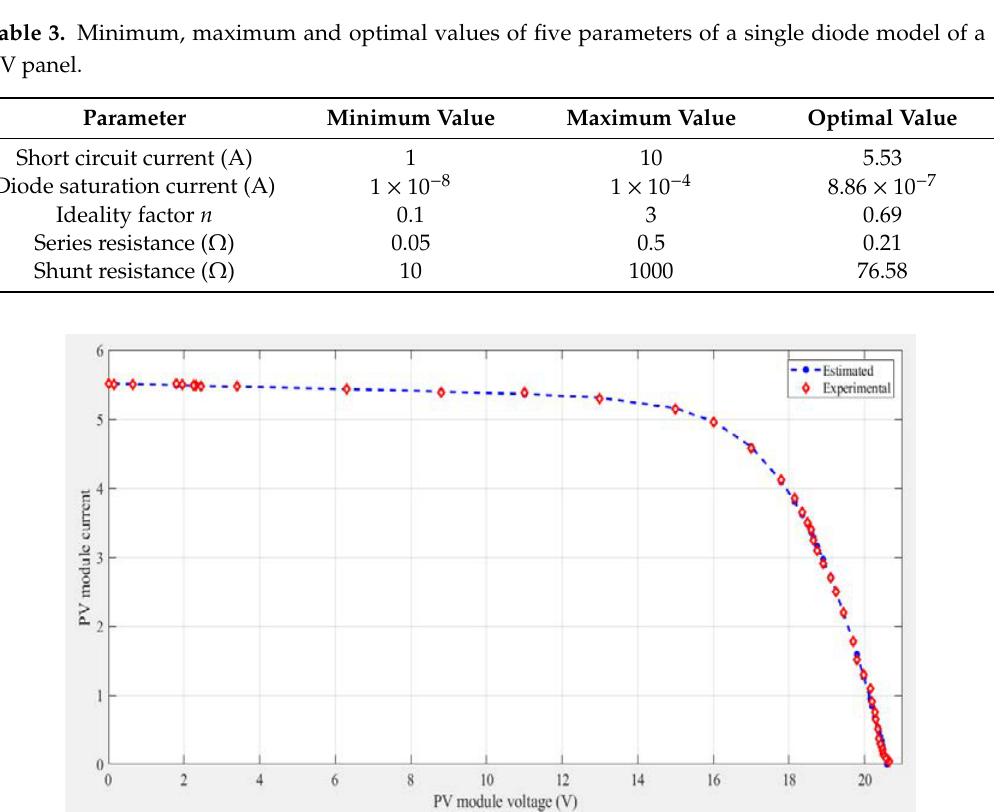
Figure 16. Cost function variation during the optimization process. 5. Conclusions In this research, the effect of the coating on the performance of the PV panel was investigated. The output power, which indicates the overall efficiency of the three solar PV panels under three different conditions, was evaluated. The first solar panel was coated with SiO 2 hydrophobic nanomaterial, and was used for the self-cleaning process. The second solar PV panel was cleaned manually every day, without a coating of any material. The last solar panel was kept during the period of the experiment without a coating and without cleaning; this was used as a reference for all measuring processes. Using hydrophobic SiO 2 coating nanomaterial improved the total performance of the solar PV panels in the following ways: • The output power, which indicates the overall efficiency of the solar PV system, was increased by 15% more than the dusty panels and 5% more than the uncoated panels which were cleaned manually every day.